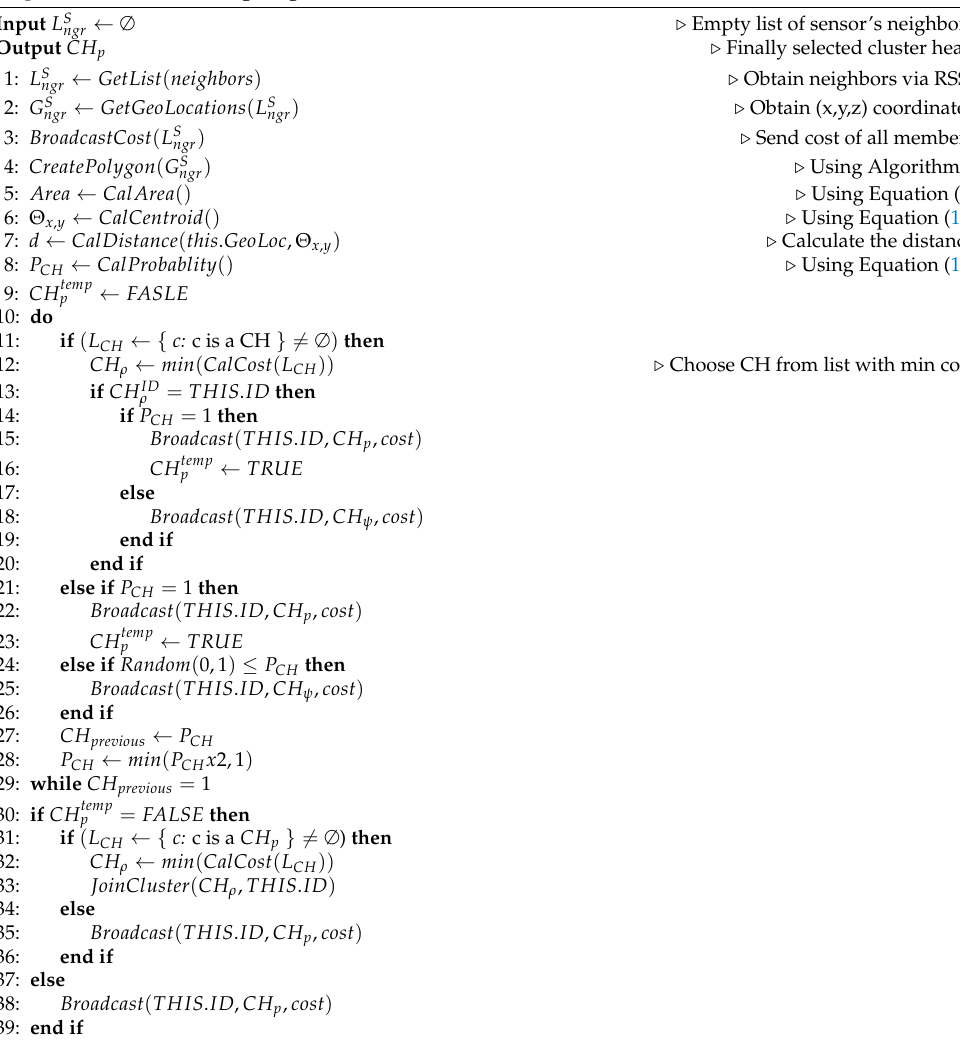
Algorithm 2 Clustering Algorithm